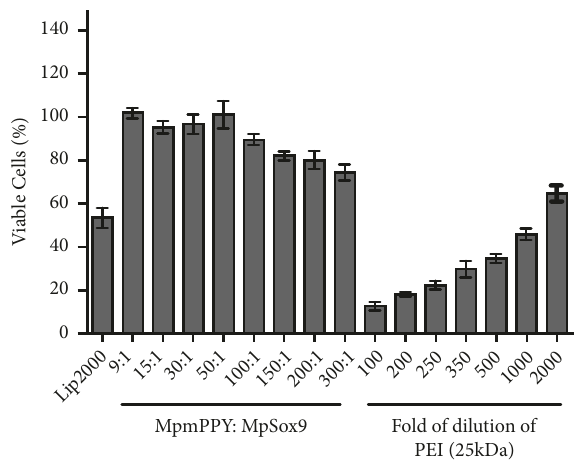
Figure 2: Cytotoxicity assay. Notes. Bar1, Lipofectamine 2000- (Lip2000-) plasmid Sox9 (pSox9); bar 2-9, pmPPY/pSox9 nanopar- ticles at various weight ratio of 9:1, 15:1, 30:1, 50:1, 100:1, 150:1, 200:1, and 300:1; bar 10-16, different folds of dilution of PEI plus pSox9, 100-, 200-, 250-, 350-, 500-, 1000-, 2000-folds from left to